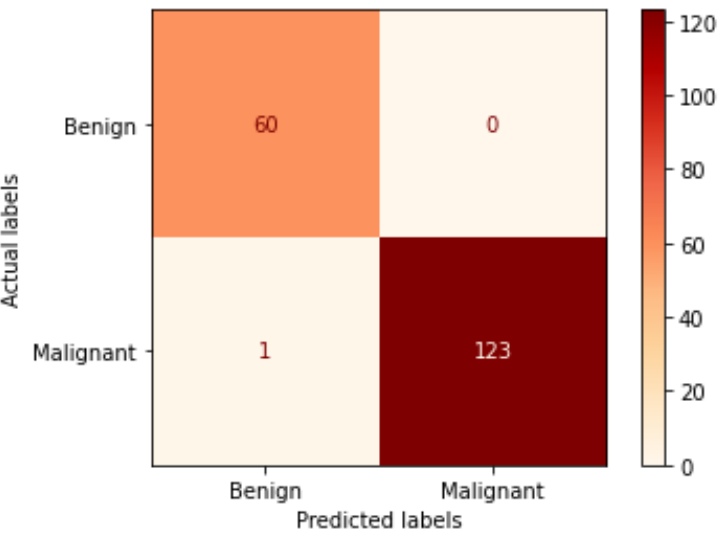
Figure 20. Confusion matrix of Xception model in 400× magnification-dependent binary classifica- tion.